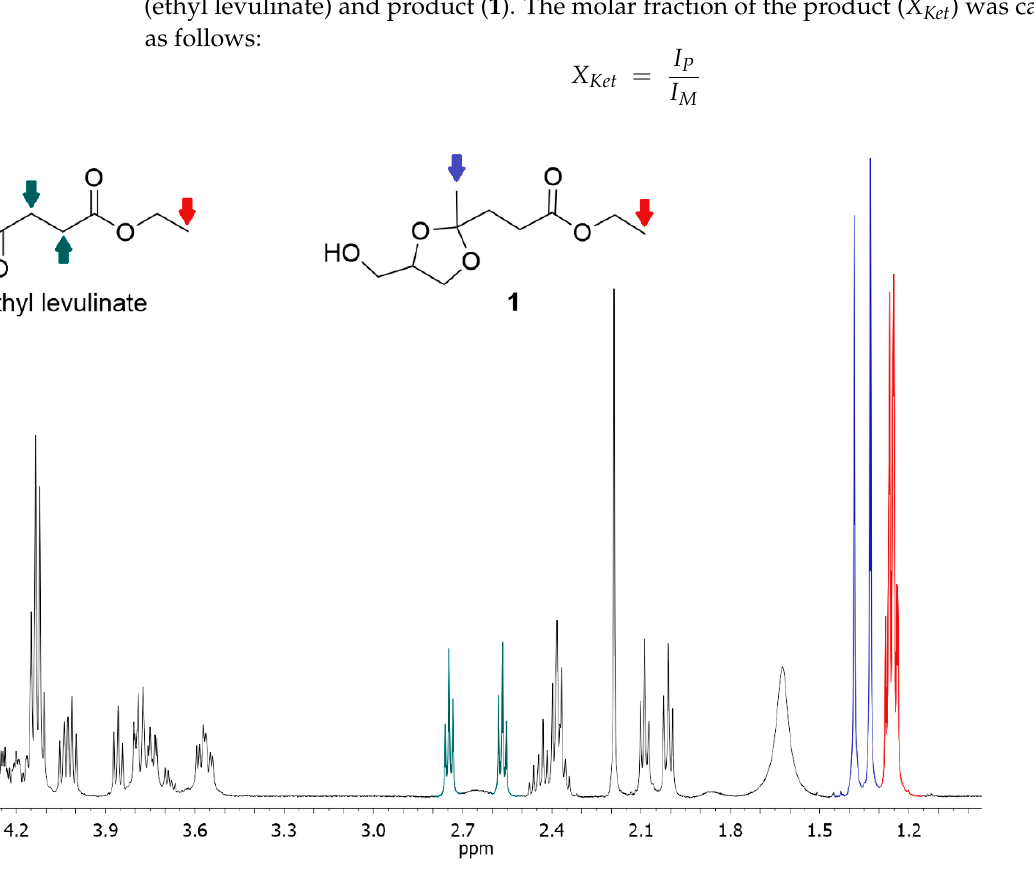
Figure 8. 1 H-NMR spectrum of a typical reaction mixture. In red, the integrals corresponding to the protons of methyls of the ethyl group of both reactant and product. In blue, the signals of protons of the methyl in alpha to the ketal carbon of the product. In green, the signals of the protons of the - C H 2 C H 2 - portion of ethyl levulinate. -C H 2 C H 2 - portion of ethyl